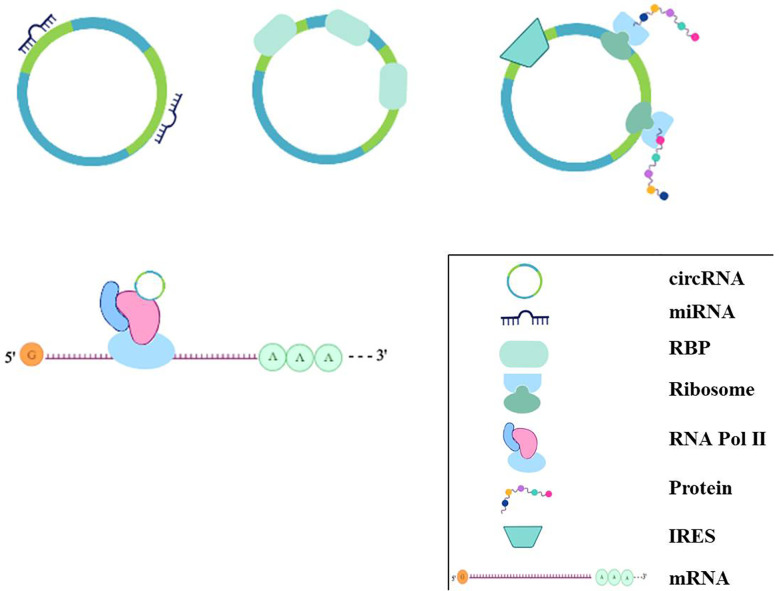
The regulation mechanisms of circRNAs. circRNAs can bind to miRNAs acting as miRNA sponges; some circRNAs can bind to protein, especially RBP, acting as sponge or decoy; some can regulate transcriptionally through interacting with RNA Pol II, or some circRNAs even have the potential role of coding for proteins by internal ribosome entry site.